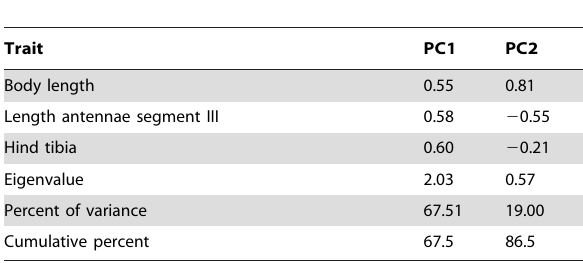
Table 1. Principal components analysis of three morphometric characters of females of Brevicoryne brassicae reared on Brassica campestris and Brassica oleracea (N